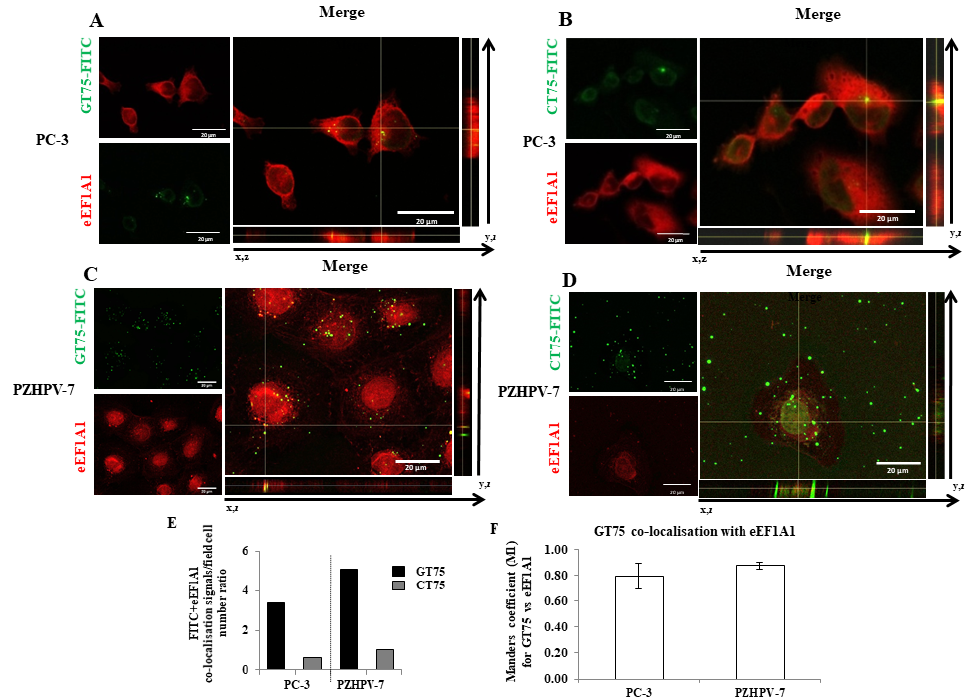
Figure 2. GT75 aptamer co-localisation with eEF1A1 protein in PC-3 and PZHPV-7 cells. Representative images of immunofluorescence confocal microscopy of the GT75-FITC aptamer (( A , C ), green, 150 nM) and control CT75-FITC (( B , D ), green, 150 nM) co-localisation (arrows in orthogonal view) with eEF1A1 protein (red), 3 h after GT75/CT75-FITC transfection in PC-3 and PZHPV-7. ( A , B ) Orthogonal views and 3D surface plots show GT75-FITC co-localisation at distinct points with eEF1A1 protein both in PC-3 ( A ) and PZHPV-7 ( C ). ( B , D ) Cellular distribution in PC-3 and PZHPV7, respectively, of the control CT75-FITC. Merge of confocal Z-stack images, objective immersion oil, 60 × , bars 20 µ m. ( E ) Number of co-localisation signals, manually counted in the overlay of different pictures randomly captured in PC-3 and PZHPV-7 transfected by GT75-FITC or CT75-FITC. ( F ) Spatial prox- imity between GT75-FITC and eEF1A1, in PC-3 and PZHPV-7, estimated by Manders’ co-localisation coefficient M1, are shown as the mean ± SEM. n = 9 (PC-3) and n = 6 (PZHPV-7). Surface plots are diagrams of three-dimensional data of the indicated cells (arrow) and are shown in grey